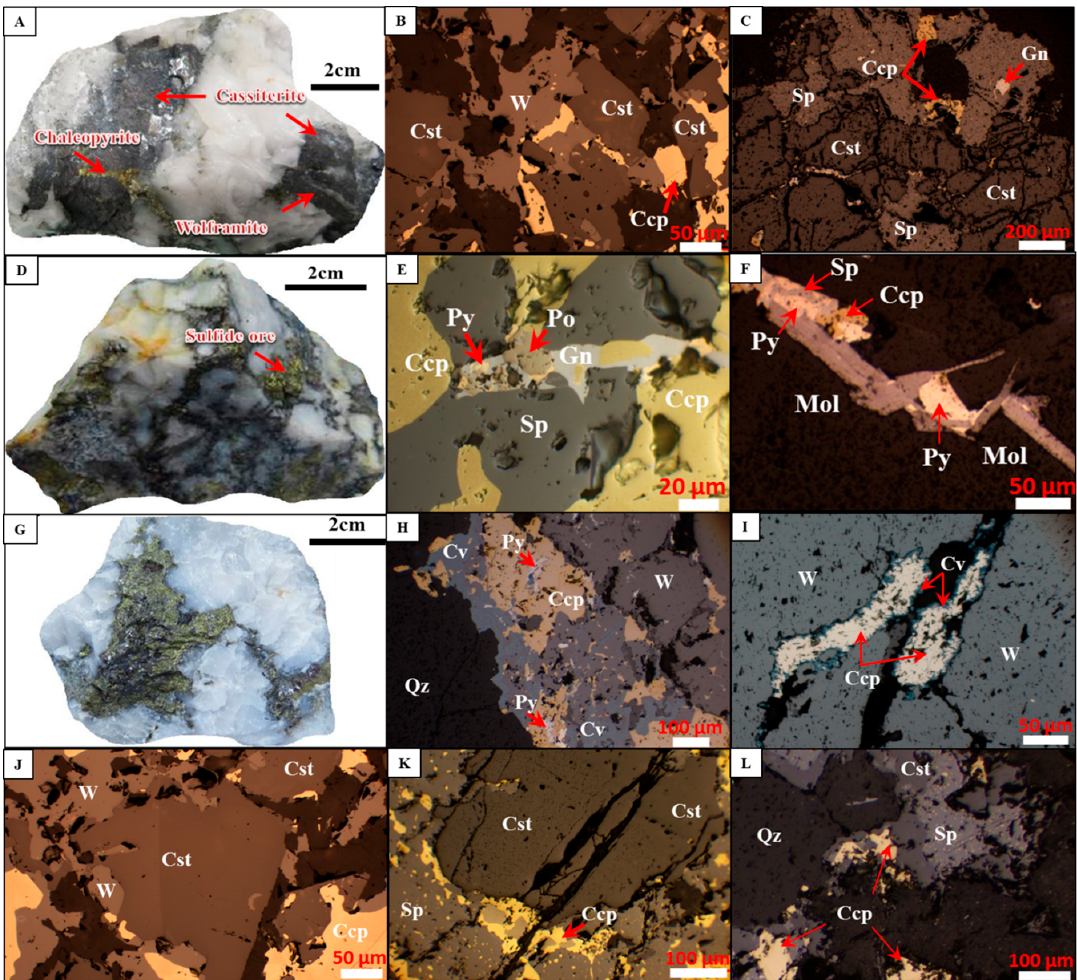
Figure 10. Photographs of Sn–W ore specimen and ore microscopic studies. ( A ). Cassiterite and wolframite mineralized quartz vein. ( B ). Cassiterite replaced by wolframite, which has fracture filling of chalcopyrite. ( C ). Sphalerite with chalcopyrite blebs replacing between the fracture of cassiterite. ( D ). Sulfide-bearing quartz vein. ( E ). Sulfide ores are coexisting and in mutual intergrowth with each other. ( F ). Molybdenite associated with other sulfide minerals. ( G ). Sulfide-bearing quartz vein. ( H ). Covellite is observed as rims replacing chalcopyrite. ( I ). Chalcopyrite with covellite rims as fracture filling between the fracture of wolframite. ( J ). Cassiterite replaced by wolframite associated with chalcopyrite. ( K ). Cassiterite replaced by sphalerite with chalcopyrite blebs. ( L ). Cassiterite replaced by sphalerite and chalcopyrite. Abbreviations: Qz = quartz, Cst = cassiterite, W = wolframite, Py = pyrite, Ccp = chalcopyrite, Po = pyrrhotite, Sp = sphalerite, Gn = galena, Cv = covellite, Mol =